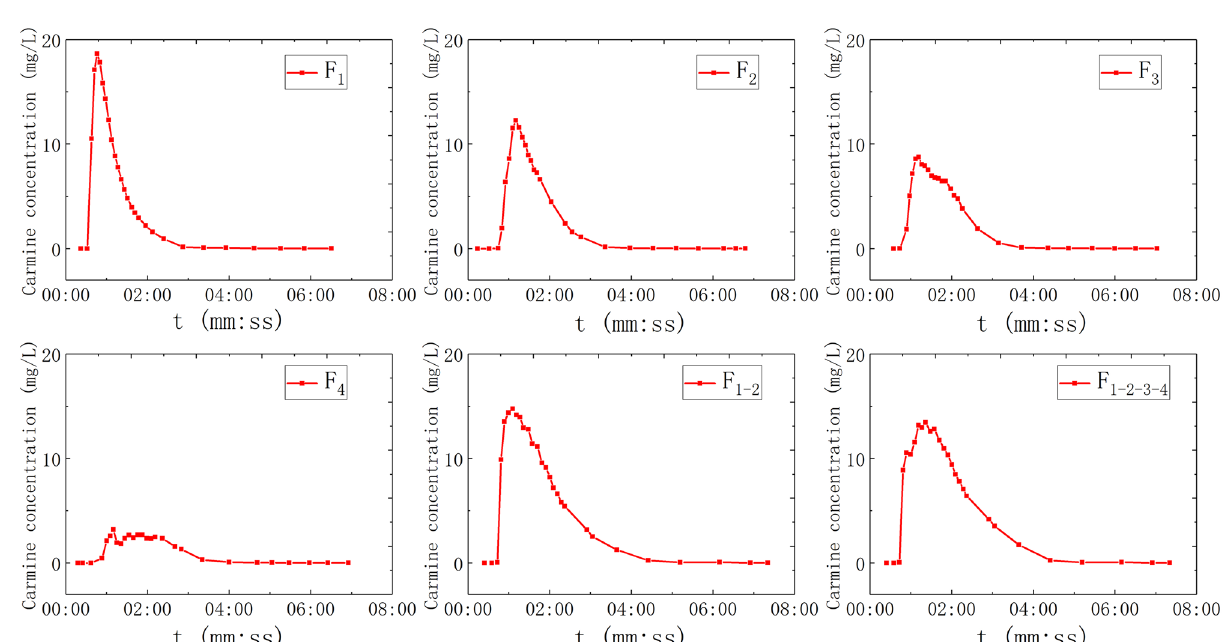
Figure 5. The BTC of solute transport under water-filling of fissure